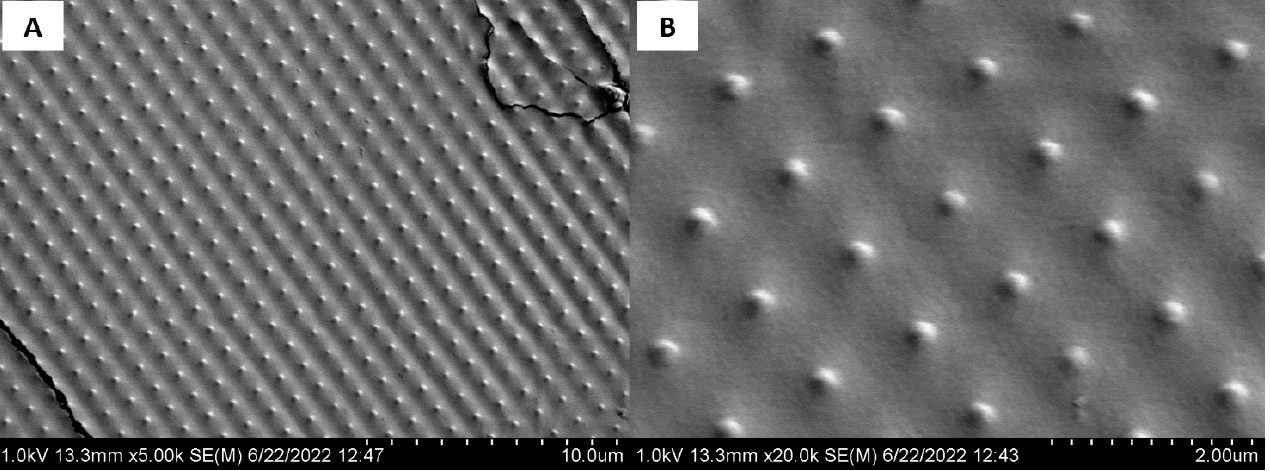
Figure 1 . Images captured using a scanning electron microscope showing the nanostructures at ( A ) 5000× and ( B ) 20,000× magnification.